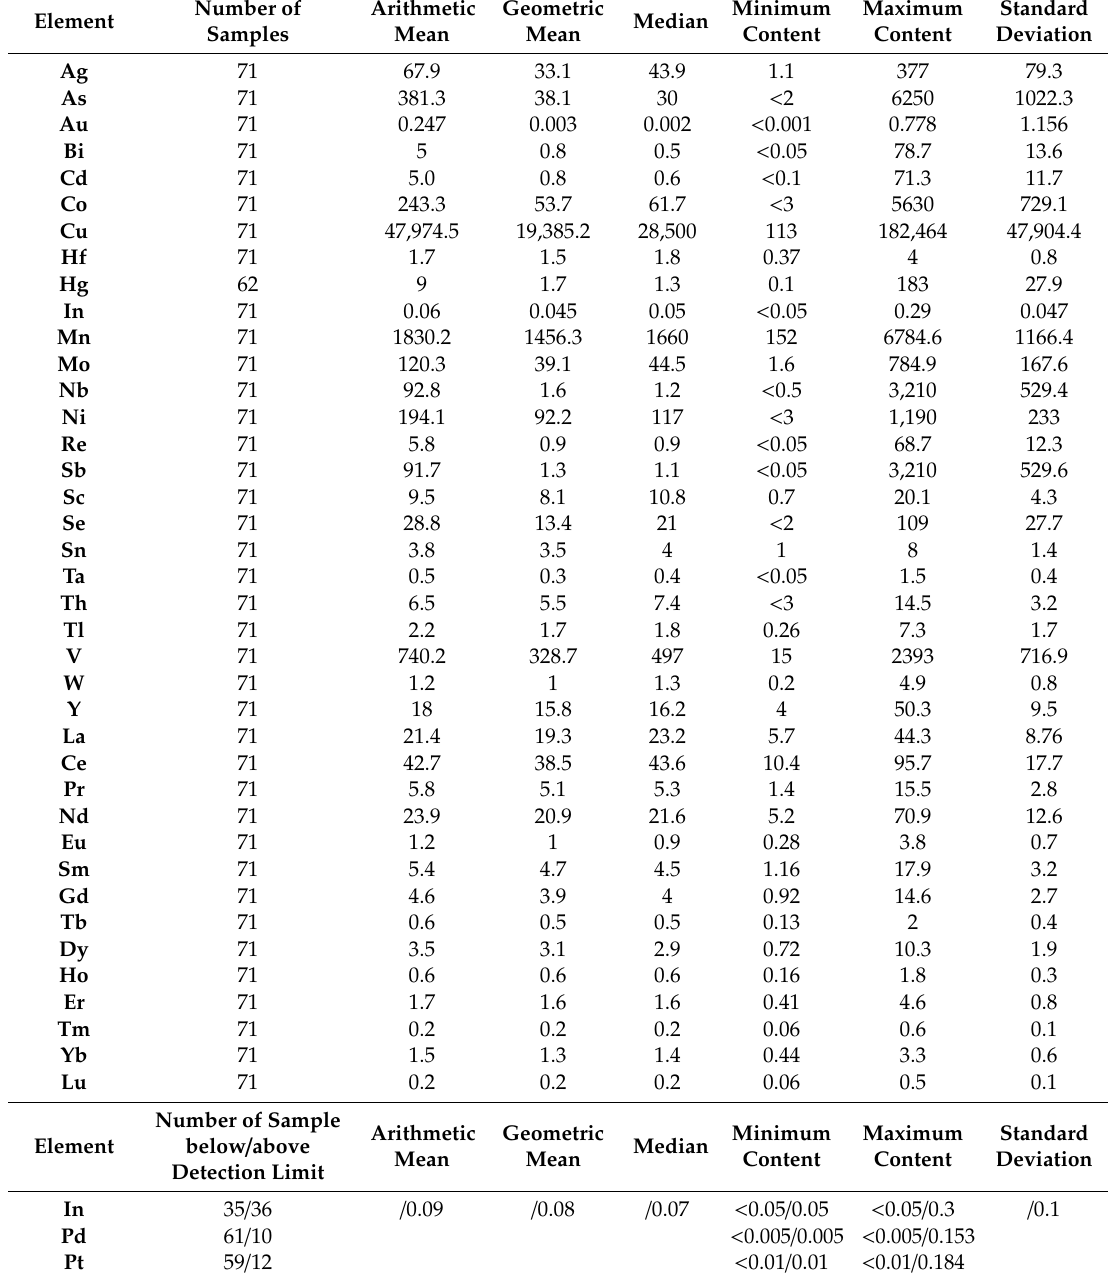
Table 6. Basic statistical parameters for main commodities (Cu and Ag) and associated trace elements (in ppm) in the bulk-rock samples of Cu-Ag ores from the Kupferschiefer deposits on the Fore-Sudetic Monocline in